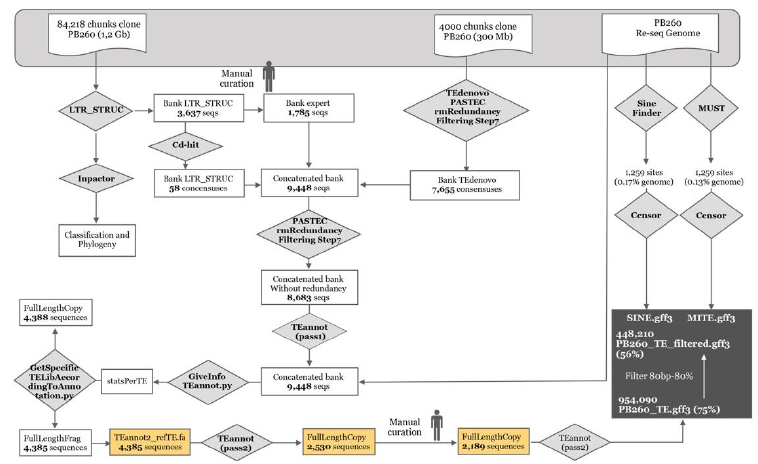
Figure 2. Detailed diagram of the transposable element annotation process implemented by the LTR_STRUCT, REPET pipeline, MUST and Sine_finder.